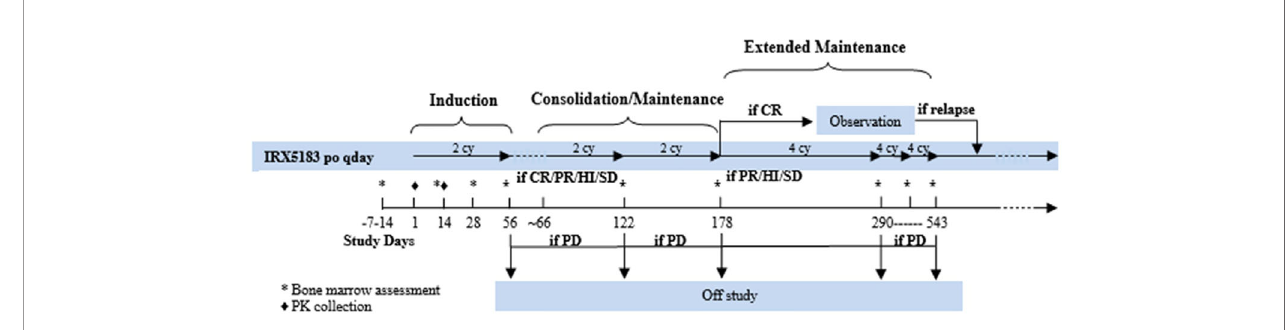
FIGURE 1 | Treatment schema of phase I clinical trial using IRX195183 in patients with high risk MDS and relapsed/refractory